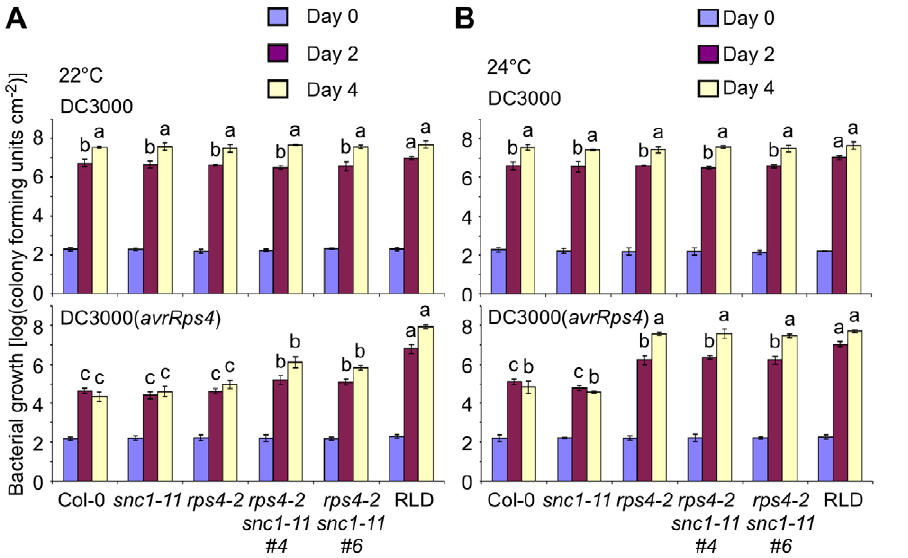
Figure 7. RPS4 and SNC1 contribute redundantly to AvrRps4-triggered resistance. In planta bacterial growth was measured in Col-0, snc1- 11 , rps4-2 , two independent snc1-11 rps4-2 lines and RLD on day 0 (blue bars), day 2 (purple) and day 4 (yellow) after inoculation with DC3000 (top) and DC3000( avrRps4 ) (bottom) at 5 6 10 4 cfu/ml at 22 u C (A) and 24 u C (B). Values represent averages of cfu/cm 2 leaf tissue from triplicate samples, and error bars denote standard deviation. Values labeled with different letters show significant differences at the indicated days as determined by Student’s t-test ( P , 0.05, n=3). This experiment was repeated three times with similar results.